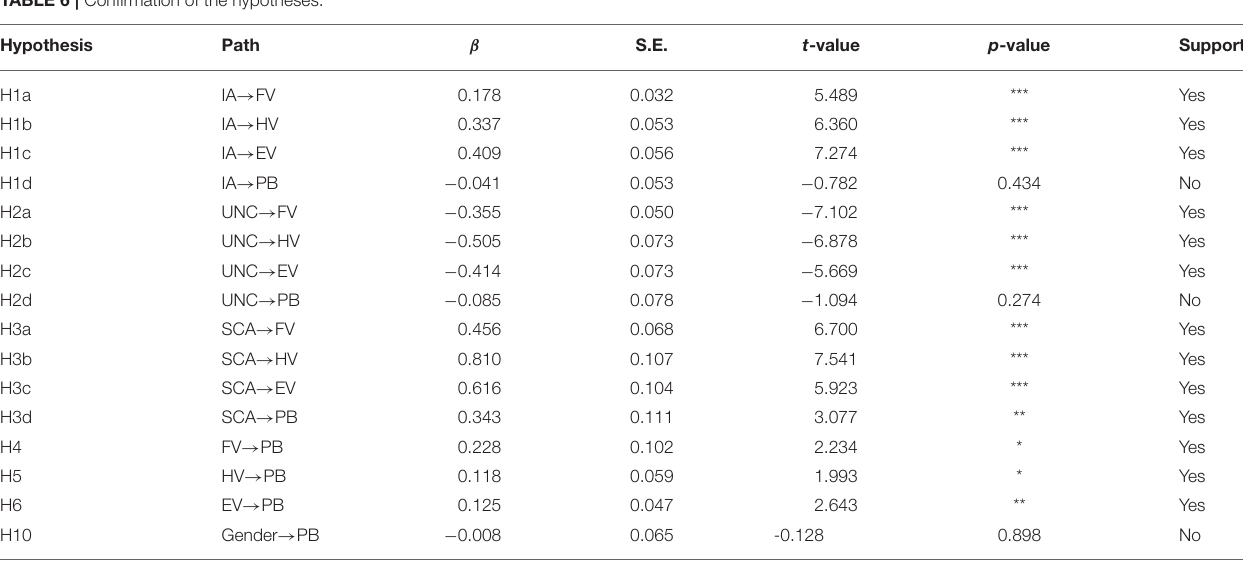
TABLE 6 | Confirmation of the